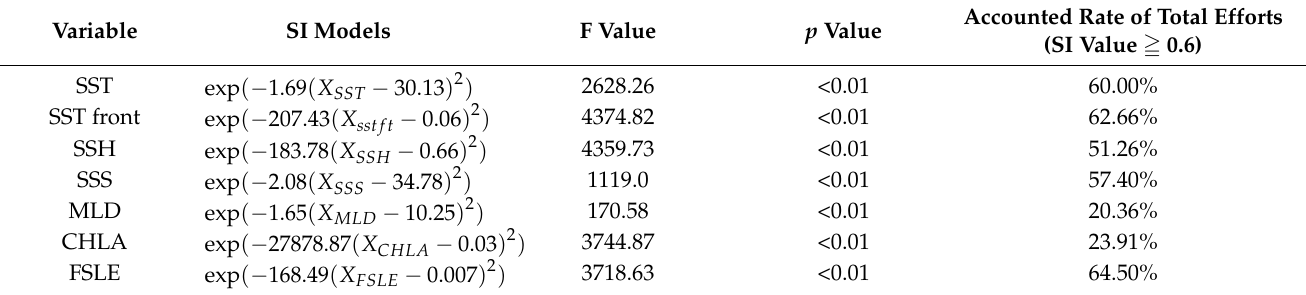
Table 2. The equations of suitability index (SI) derived from environmental